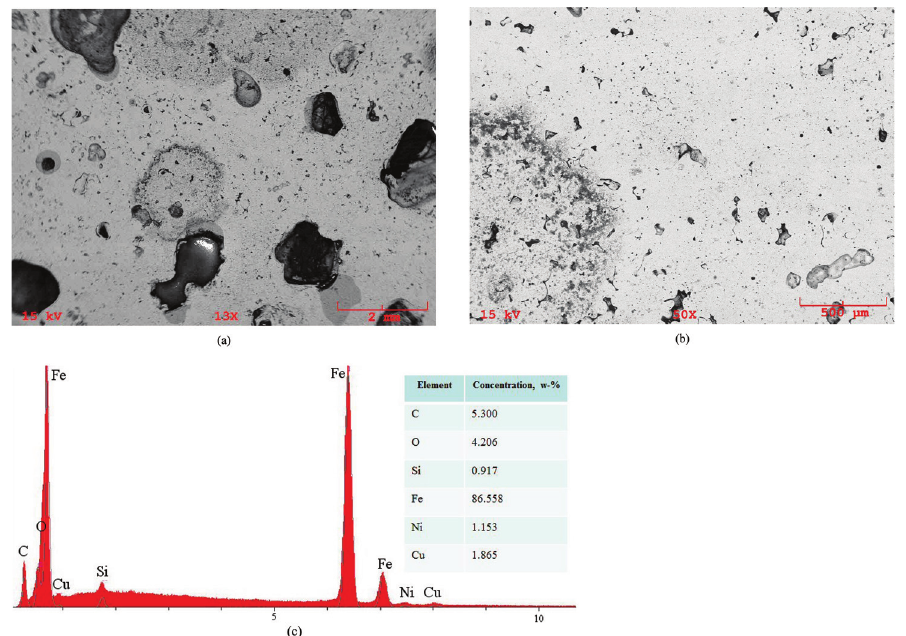
Figure 2: (a) and (b) SEM micrographs of solidified sponge iron after reduction by solid þ gas reductants (coal þ H 2 ), (c) EDS analysis of matrix illustrated in (b).